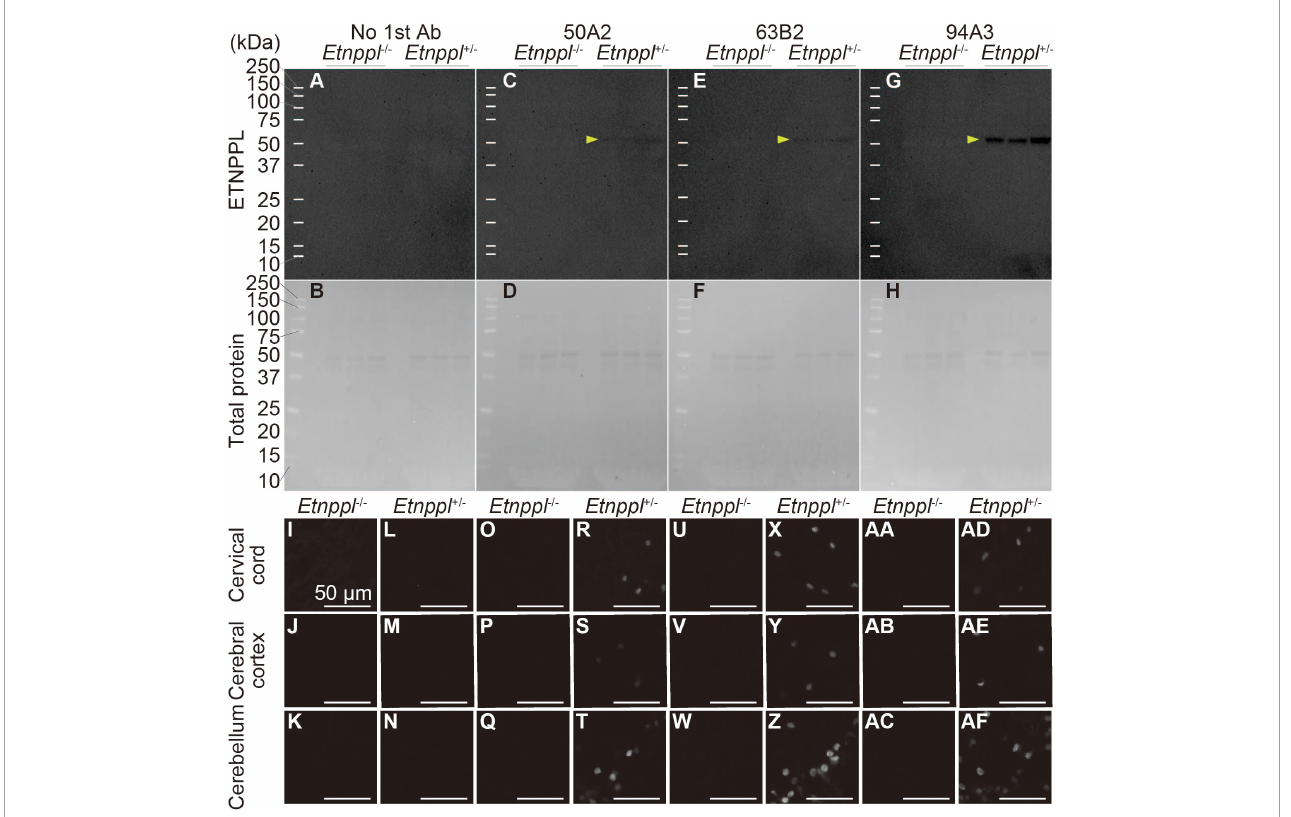
FIGURE3 Specificity of anti-ETNPPL monoclonal antibodies. (A–H) Western blotting using anti-ETNPPL monoclonal antibodies. Black indicates the signal for ETNPPL (A,C,E,G) or the total protein (B,D,F,H) . Anti- ETNPPL monoclonal antibody clones 50A2 (C,D) , 63B2 (E,F) , or 94A3 (G,H) were used as primary antibody, or no primary antibody was applied (A,B) . Three samples were used for each group, and the lanes between each group or marker were empty lanes. Yellow arrowheads indicate the bands corresponding to the molecular weight of ETNPPL (55.5 kDa). (I–AF) Immunohistochemistry with anti-ETNPPL monoclonal antibodies. Enlarged images of the cervical cord (I,L,O,R,U,X,AA,AD) , cerebral cortex (J,M,P,S,V,Y,AB,AE) , and cerebellum (K,N,Q,T,W,Z,AC,AF) of Etnppl − / − (I–K,O–Q,U–W,AA–AC) and Etnppl + / − mice (L–N,R–T,X–Z,AD–AF) are shown. Clones 50A2 (O–T) , 63B2 (U–Z) , 94A3 (AA–AF) were applied, or no primary antibody was applied (I–N) . Scale bars: 50 µ